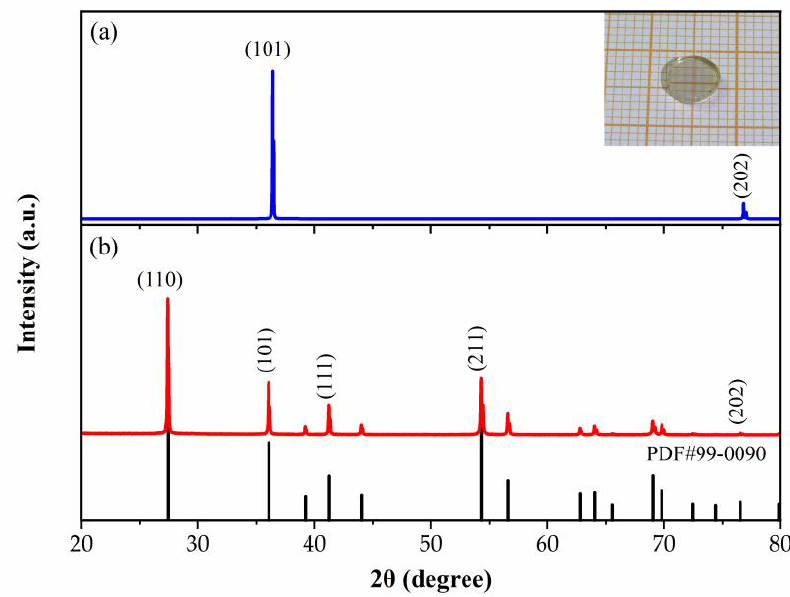
Figure 6. Different forms of ( a ) crystal wafer and ( b ) single crystal powder of XRD